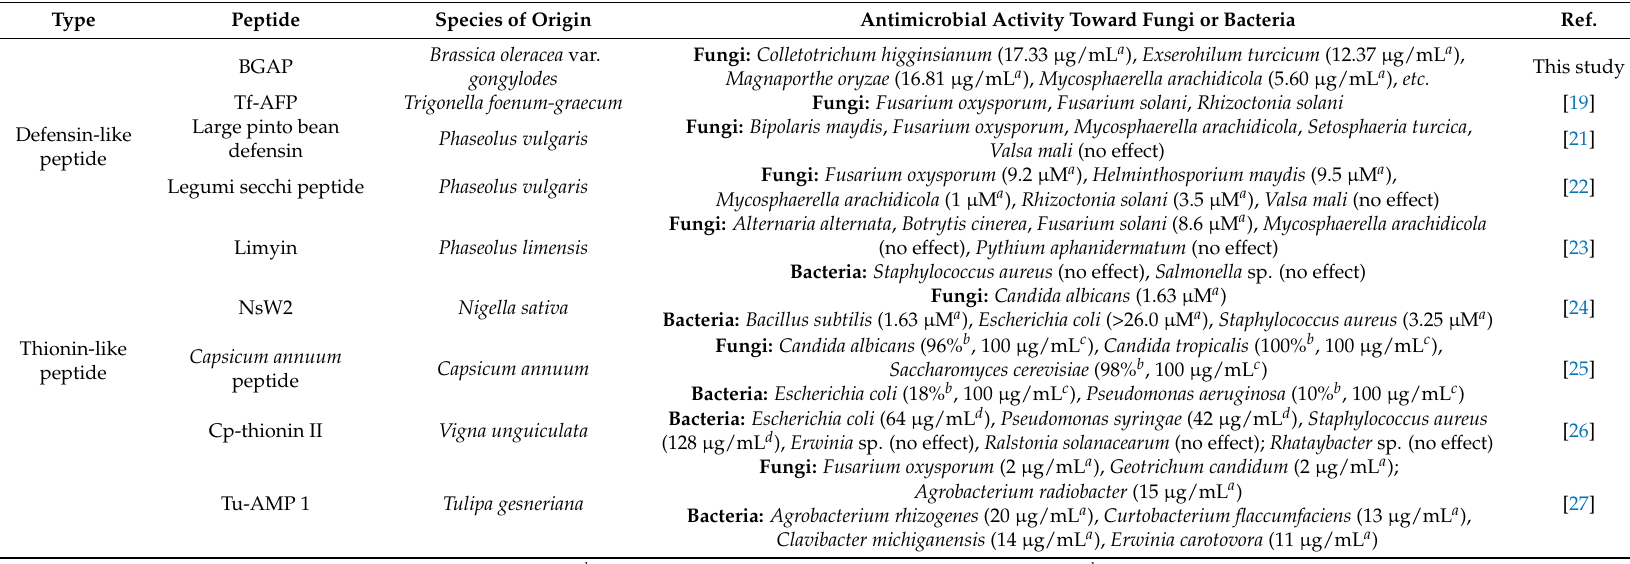
Table 2. Comparison of antimicrobial activity of BGAP with defensin-like peptides and thionin-like peptides isolated from other plants.